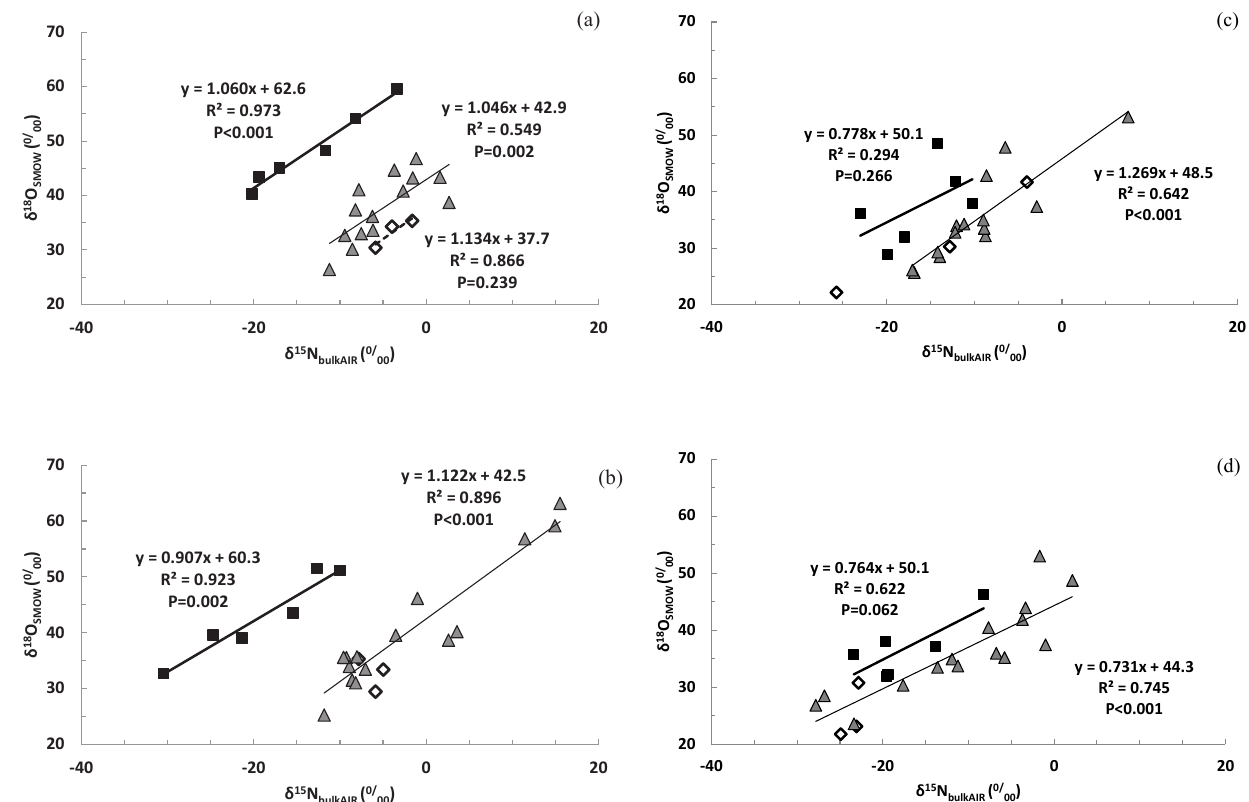
Figure 4. δ 18 O vs. δ 15 N bulk in all treatments for three periods: “ − 1”, with δ 18 O vs. δ 15 N bulk values 1 day prior to the moisture adjustment (and N and C application); “1–2”, with values in the first 2 days after the addition of water, N and C, and N 2 O emissions were generally increasing in all treatments; and “3–12”, the period in days after moisture adjustment and N and C addition when N 2 O emissions generally decreased back to baseline soil emissions (day − 1 in diamond symbols, days 1–2 in square symbols and days 3–12 in triangle symbols) in the experiment. (a) SAT/sat treatment, (b) HALFSAT/sat, (c) UNSAT/sat and (d) UNSAT/halfsat. Equations of fitted functions and correlation coefficients are shown. Correlations are unadjusted; the P value tests whether the slope is different from